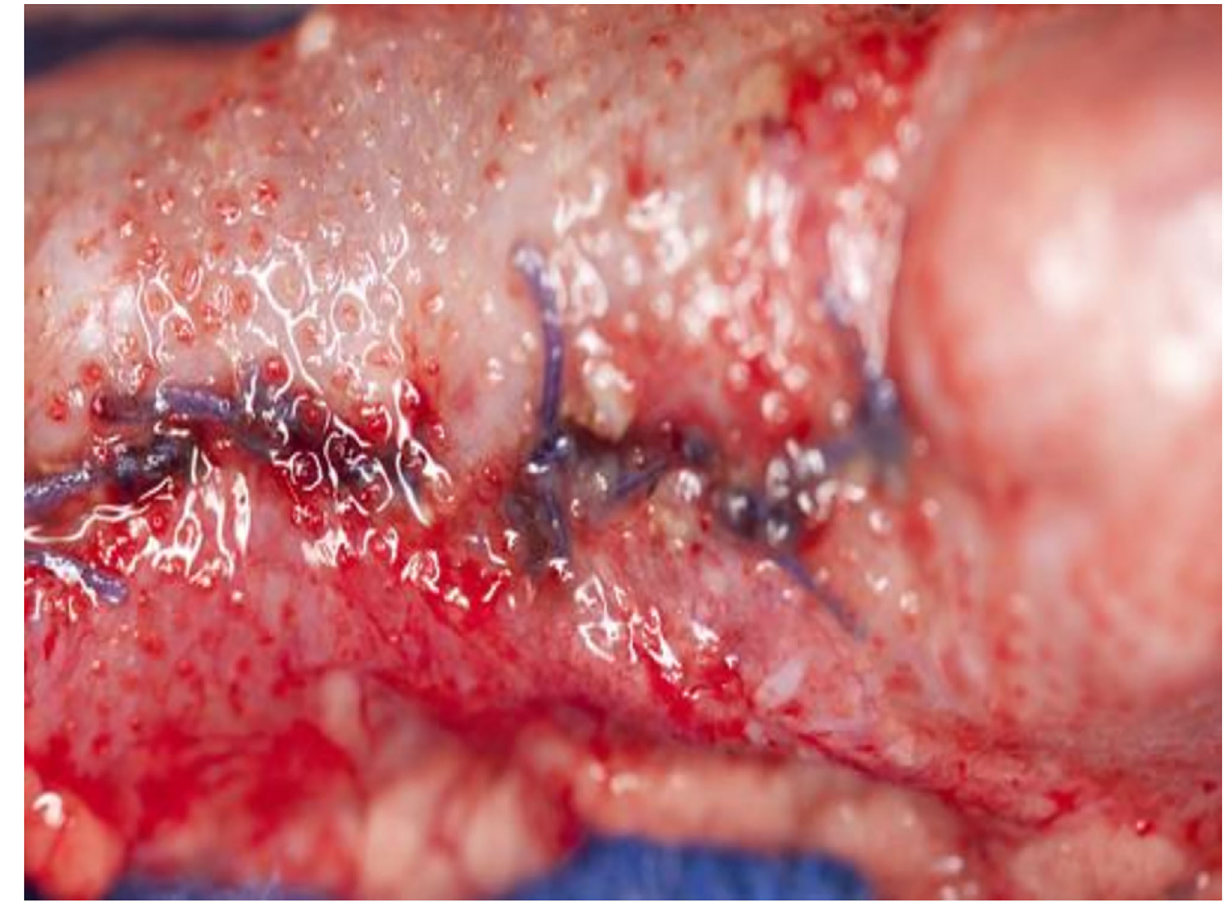
Frontiers in Surgery |